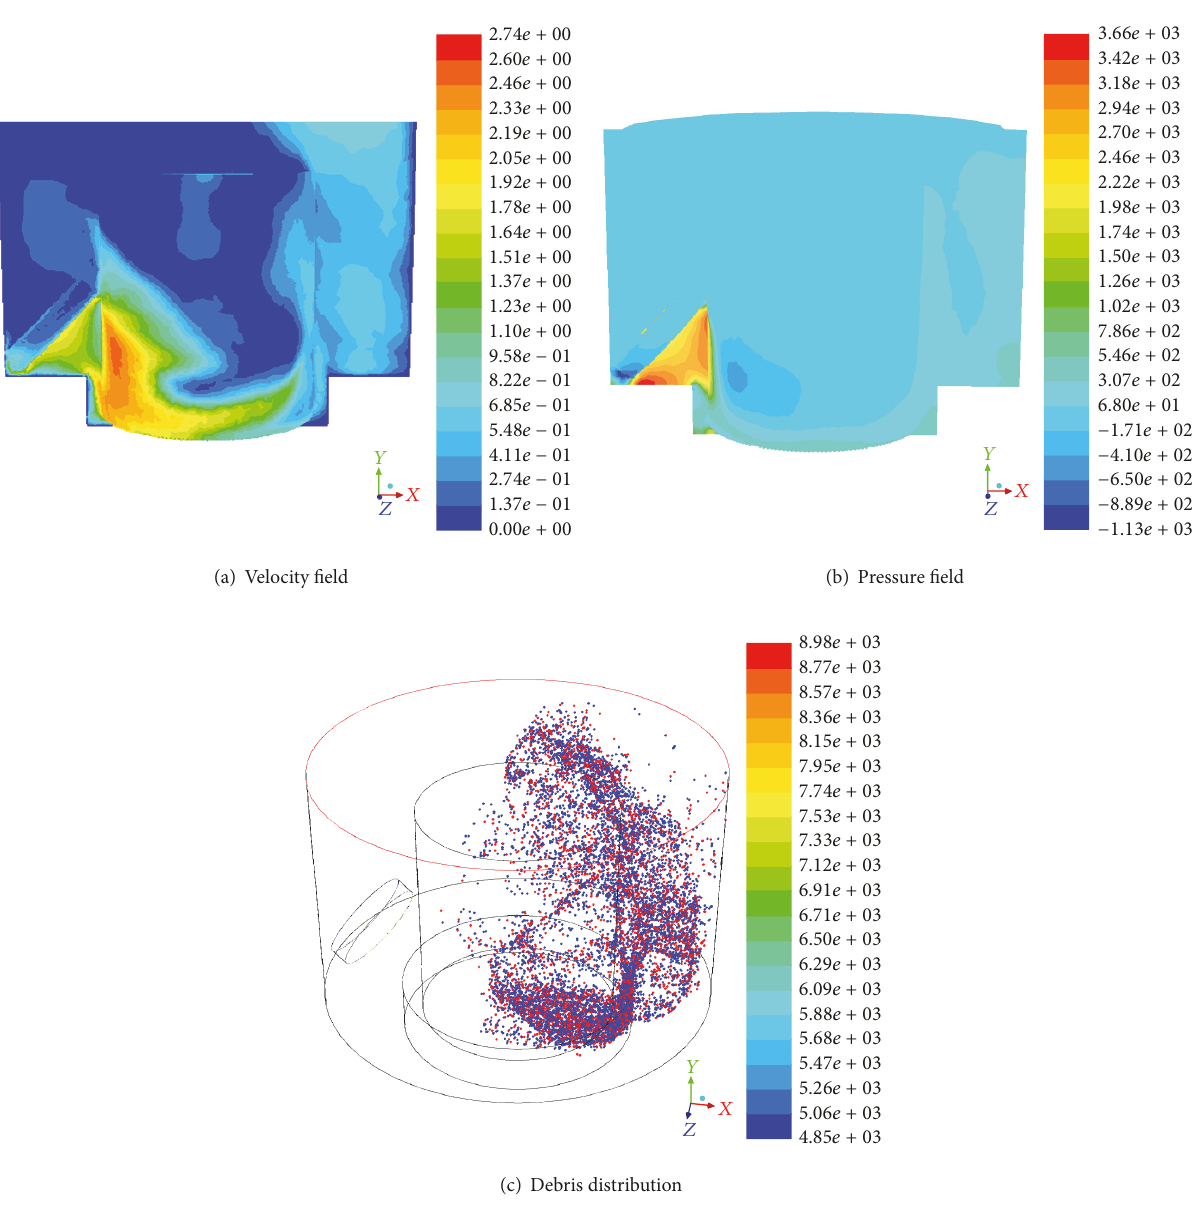
Figure 12: Schematics of gap flow field with flushing at 2 m/s and 0.5 mm deep